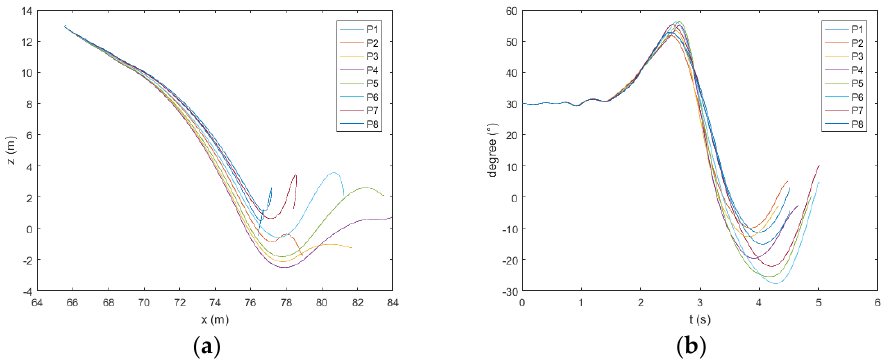
Figure 22. Trajectory ( a ) and pitch ( b ) of the lifeboat freefall when the wave height is 4 m.